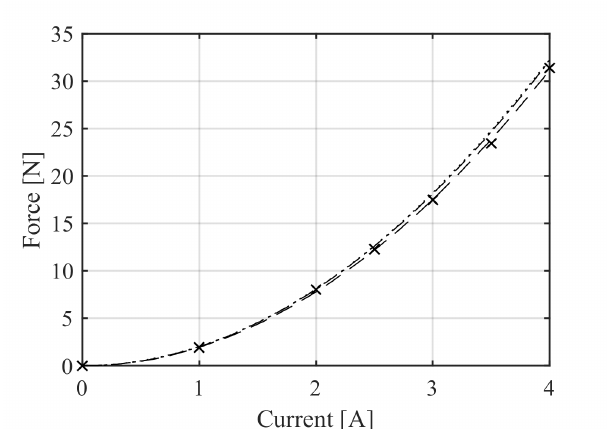
Figure 6. Numerical and experimental forces generated by the system based on the soft magnetic journal at 0.55 mm air gap: experimental data (cross); 2D model with magnetic air gap (dashed); 2D model with geometric air gap (dash-dotted); 3D model with geometric air gap (dotted). The dotted and dash-dotted lines are